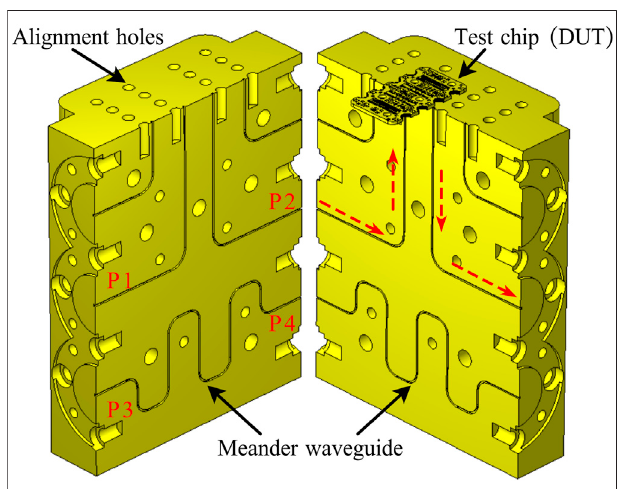
FIGURE 6 | Structure of the test fi xture, the red dotted arrows represent the direction of signal